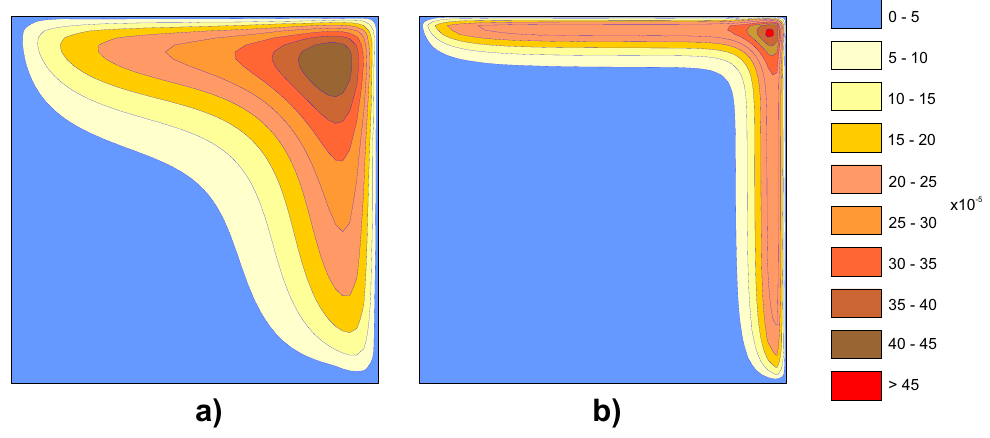
Figure 4. Example No. 1—contours of absolute errors, ( a ) Pe = 10, ( b ) Pe = 30.